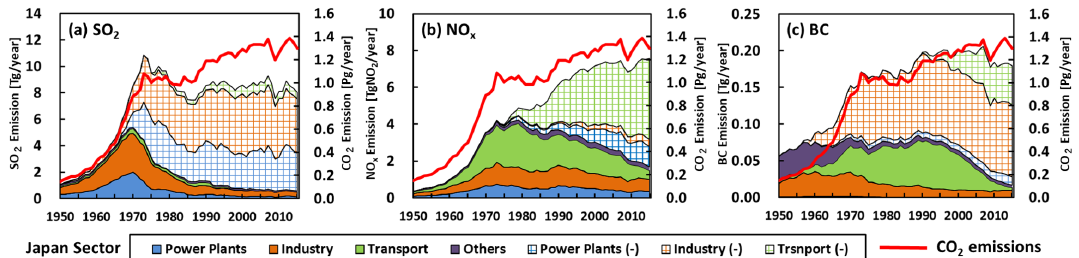
Figure 5. Emissions of (a) SO 2 , (b) NO x , and (c) BC from each major sector in Japan during 1950–2015. Solid colored areas are actual emissions, and hatched ones (–) are reduced emissions due to control measures. Red lines in the panels are total CO 2